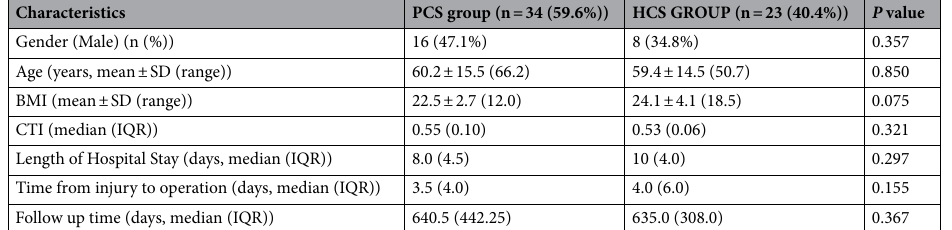
Table 1. General characteristics of patients in different internal fixation groups. SD and IQR stand for standard deviation and interquartile range